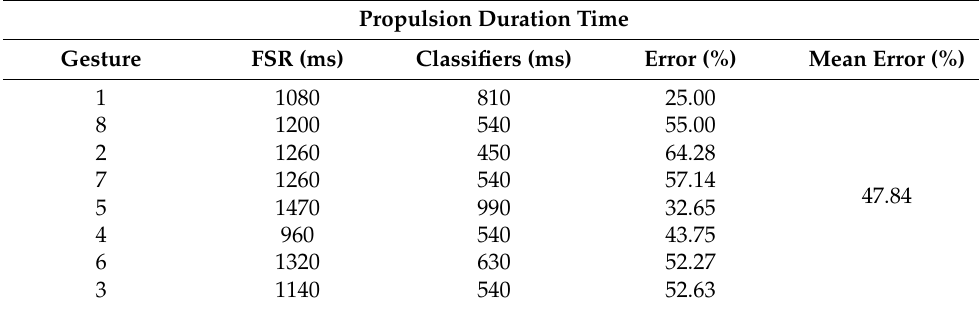
Table 9. Propulsion duration time results from WISP and force